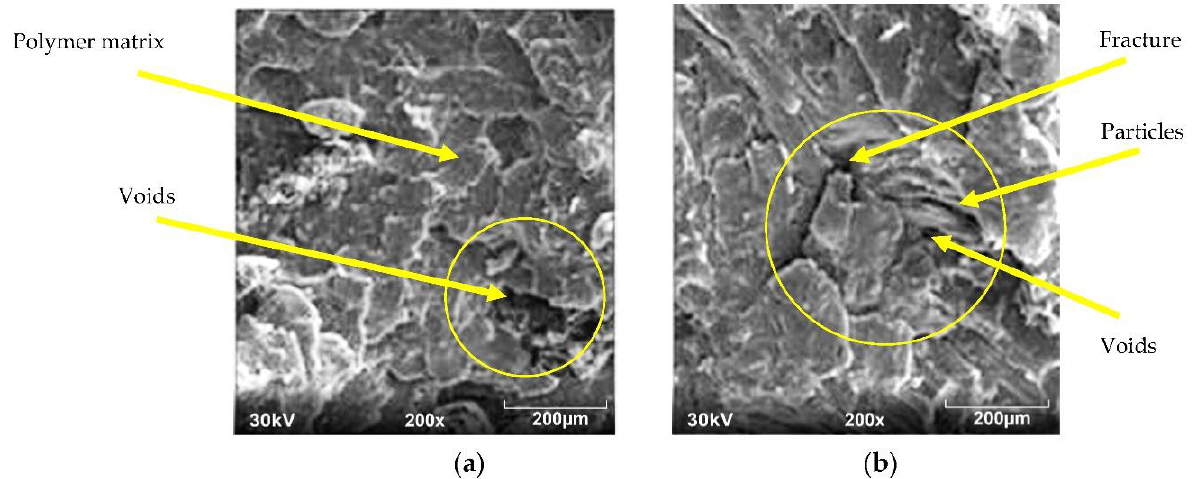
Figure 9. SEM images of the tensile fracture surfaces of the CCWW particles-epoxy-composites specimens (200 × ): ( a ) CP5 and ( b ) CP6.